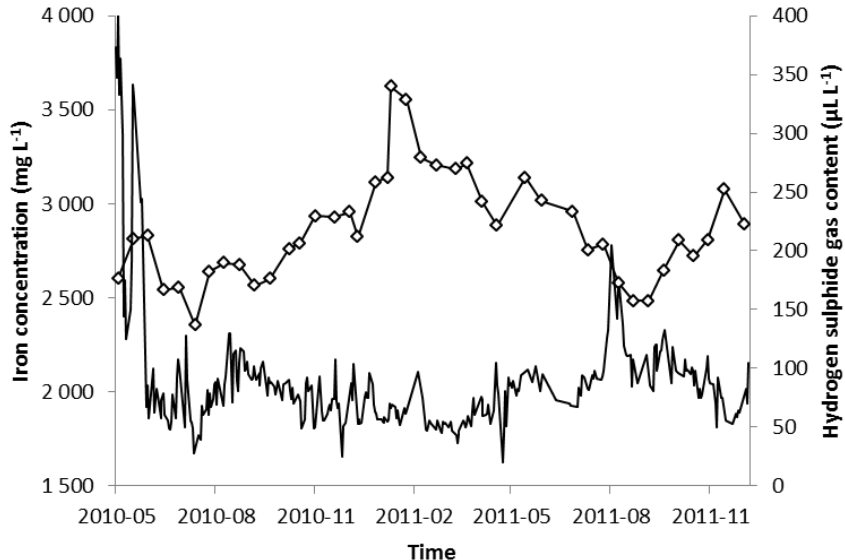
Figure 4. Negative correlation between hydrogen sulphide (—) and iron concentration in the digester at the Norrköping biogas plant